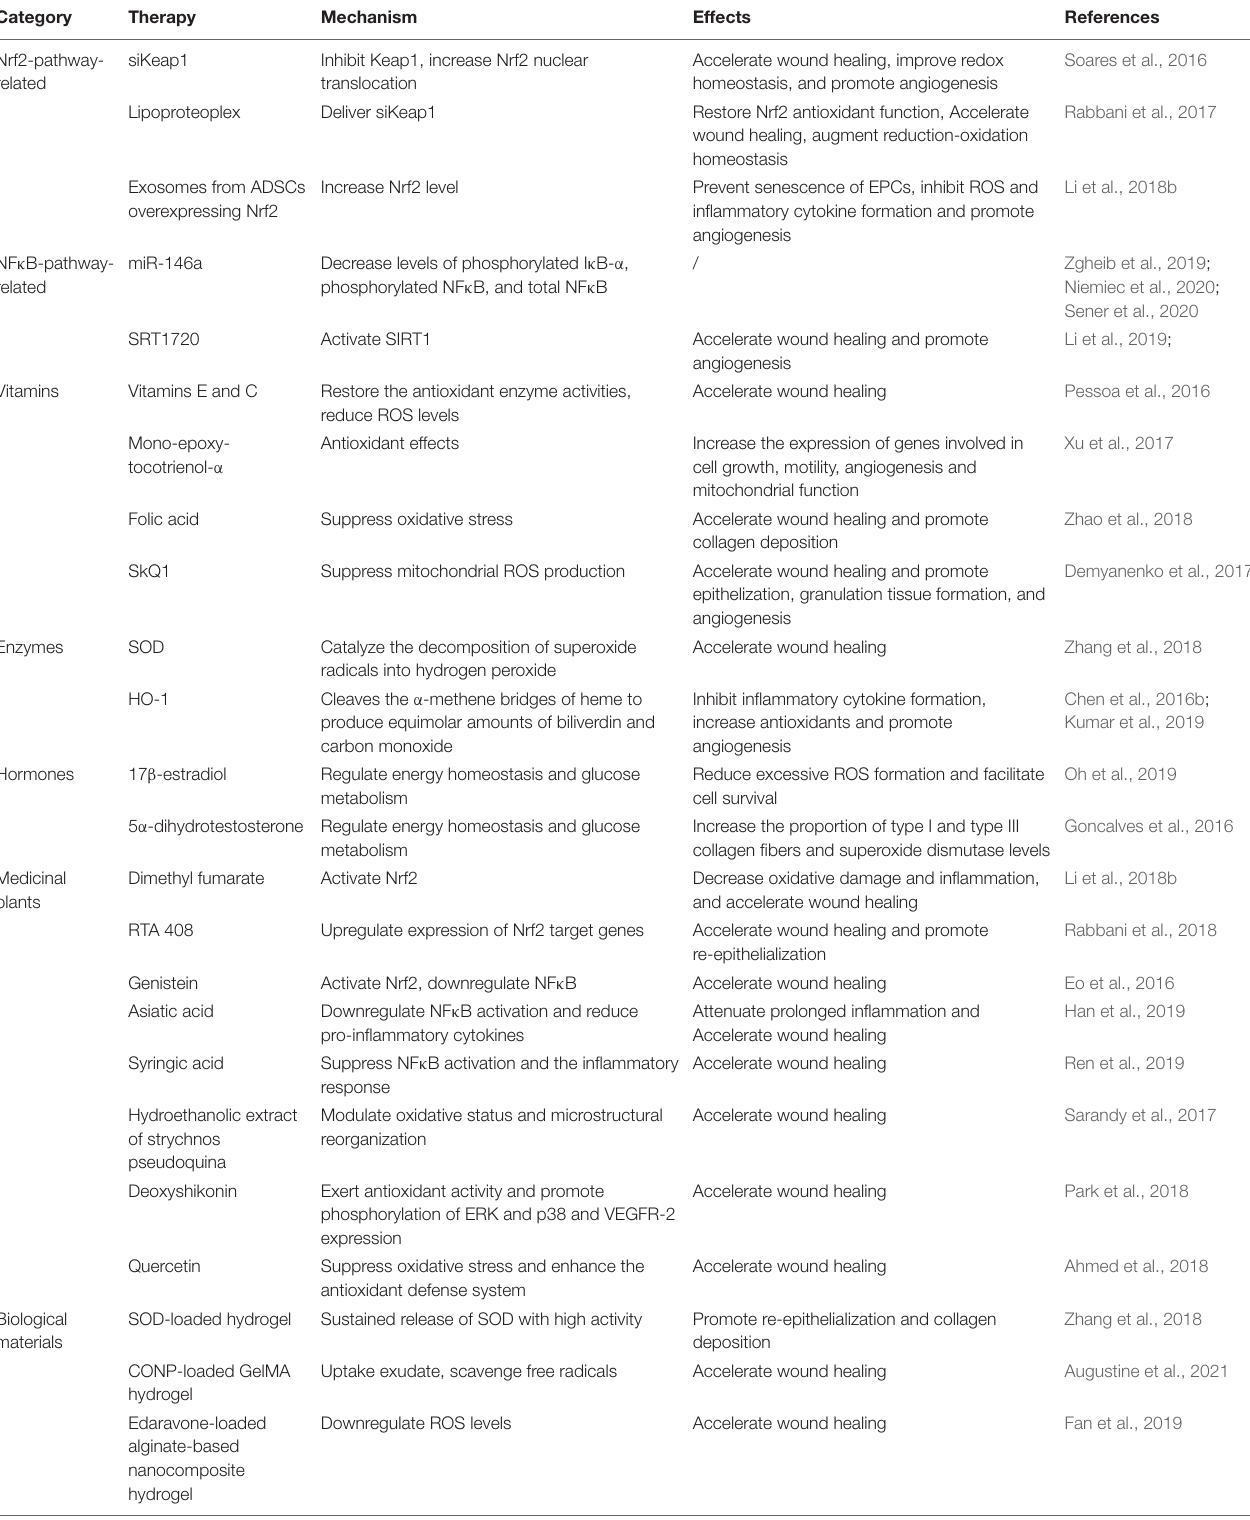
TABLE 1 | Antioxidant therapies used in diabetic wounds reported in the past 5 years (2016 –